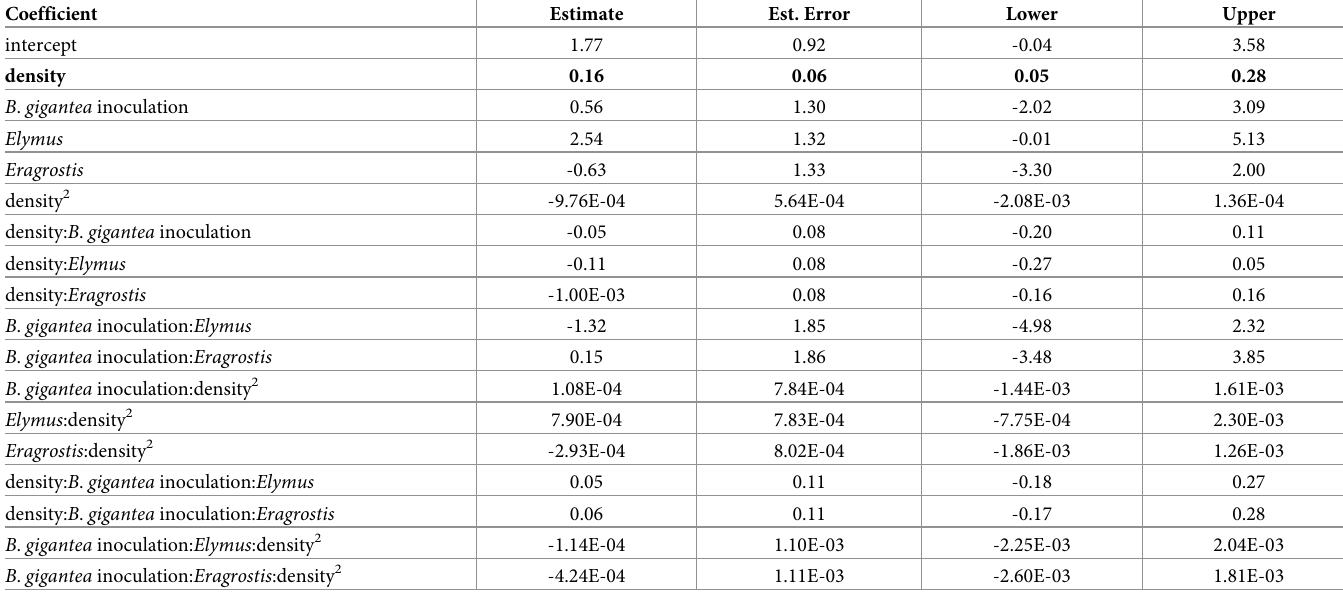
Table 2. Microstegium biomass